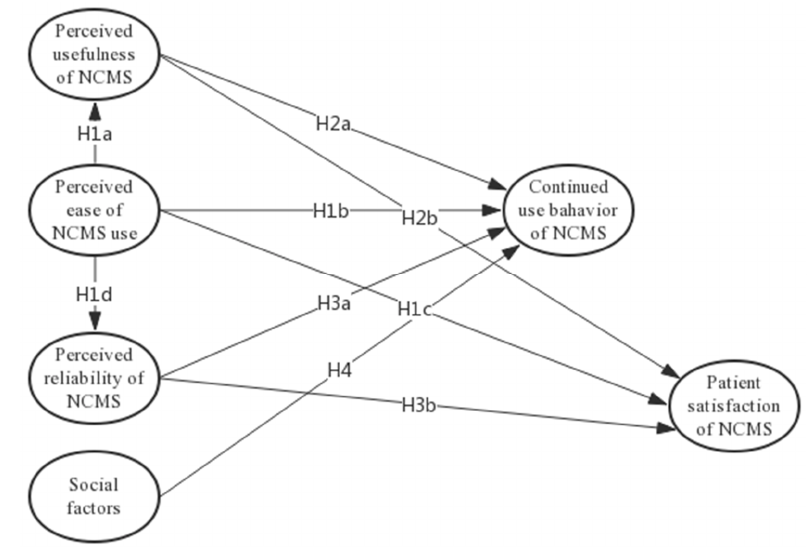
Figure 1. Research Model.